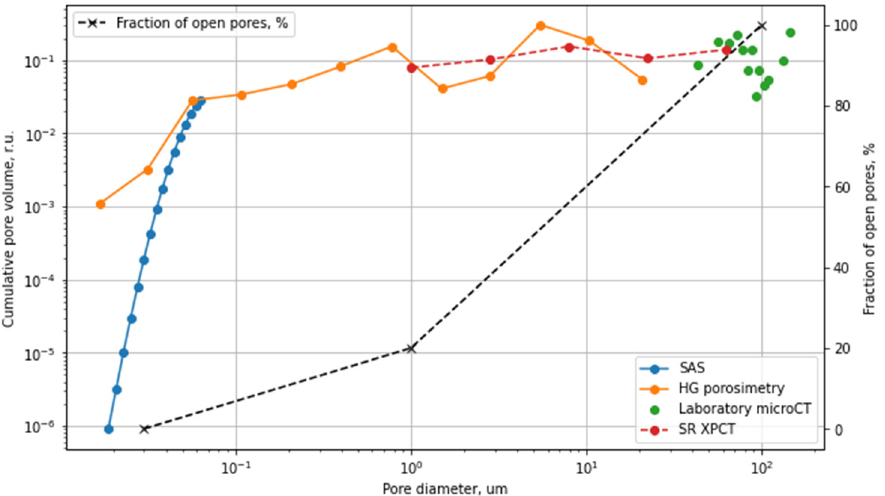
Figure 8. Cumulative pore size and the fraction of opened pores obtained by different methods.